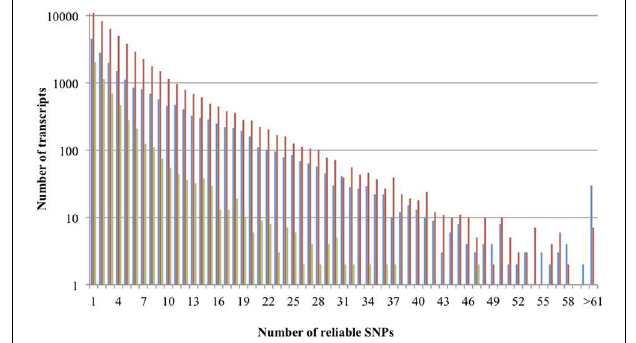
FIGURE 3 | Number of proteins (blue bars) and their respective transcripts (red dots) in which they were identified for relevant protein functions in the sampled